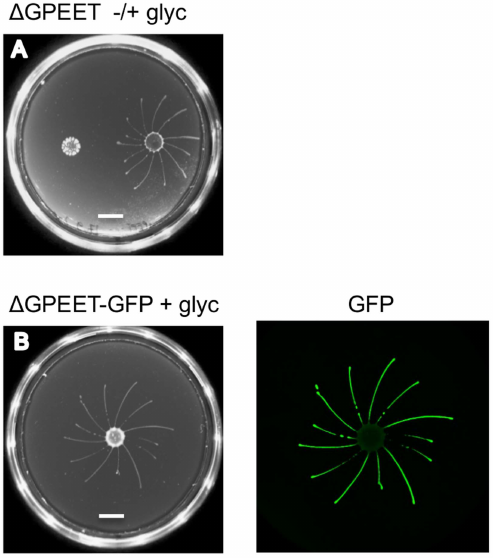
Figure 3. GPEET is not essential for SoMo. (A) 2 6 10 5 D GPEET cells, cultured with or without glycerol, were inoculated onto a plate containing 20 mM glycerol. Four days post plating only the cells cultured in medium containing glycerol showed SoMo. The scale bar is